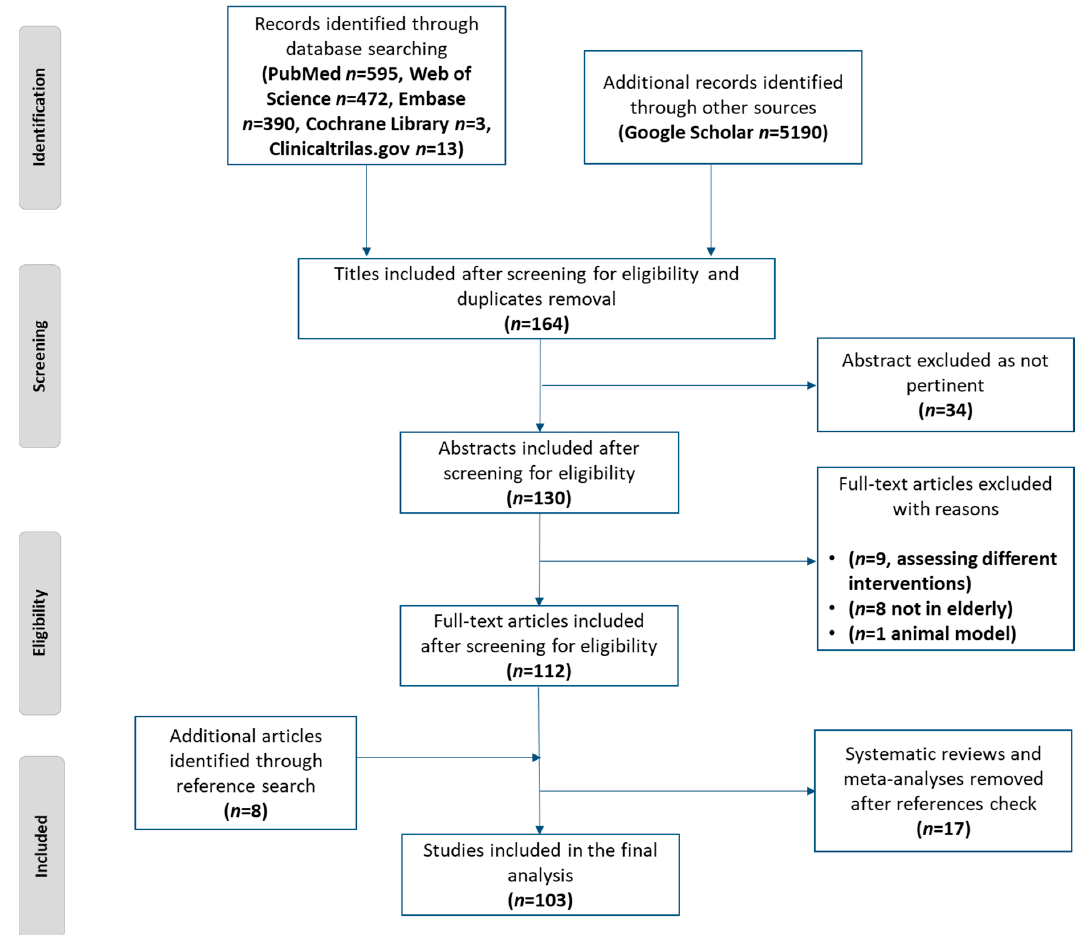
Figure 1. Preferred Reporting Items for Systematic Review and Meta-Analyses (PRISMA) flow diagram of the literature screening